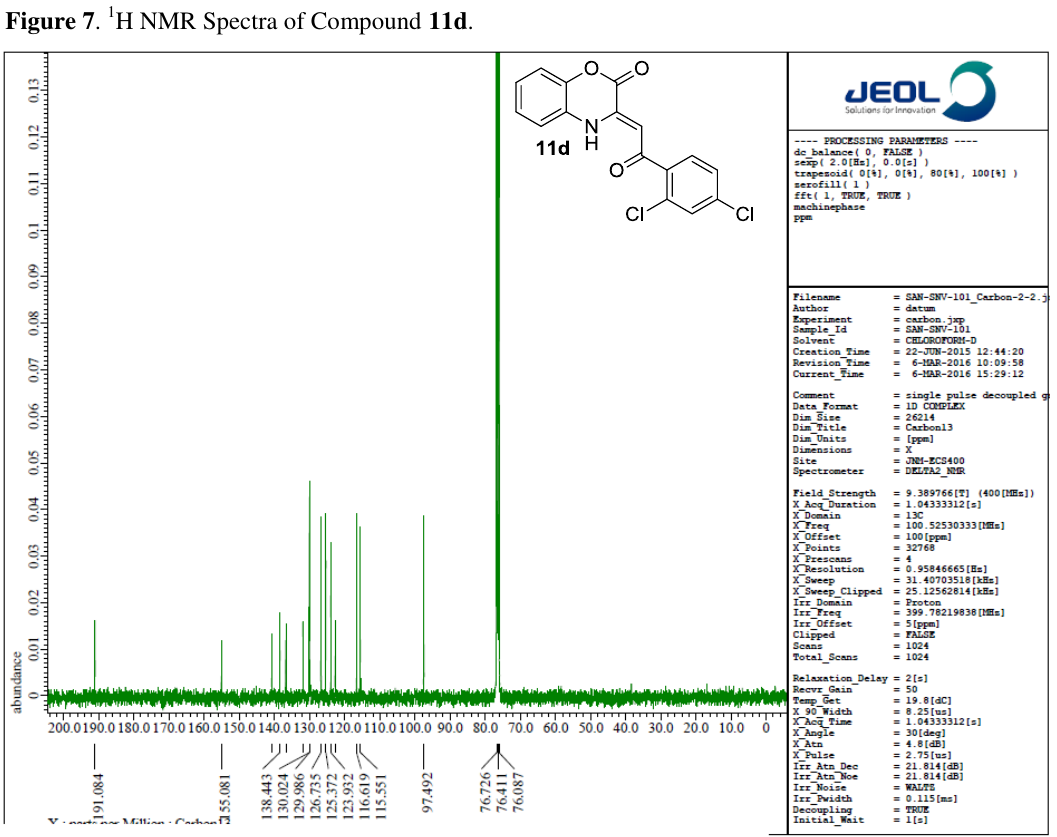
Figure 8 . 13 C NMR Spectra of Compound 11d